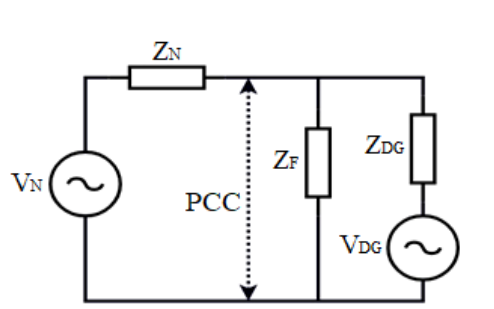
Figure 3. Equivalent per phase circuit of test